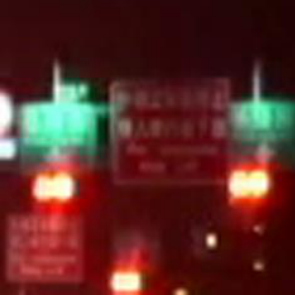
Figure 17. A traffic sign resembling vehicle tail-lights. Sensors 2017 , 17 , 2199